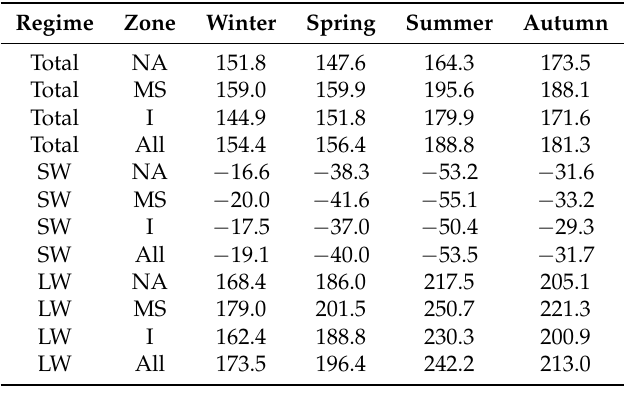
Table 3. Seasonal mean values of WVRE by regime and zone. Values are in Wm − 2 . Seasons are winter